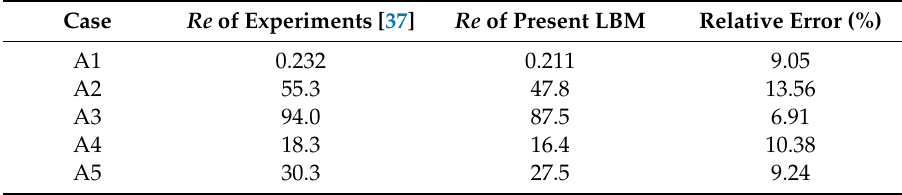
Table 2. Comparison of Re obtained from the present LBM and the experimental results.